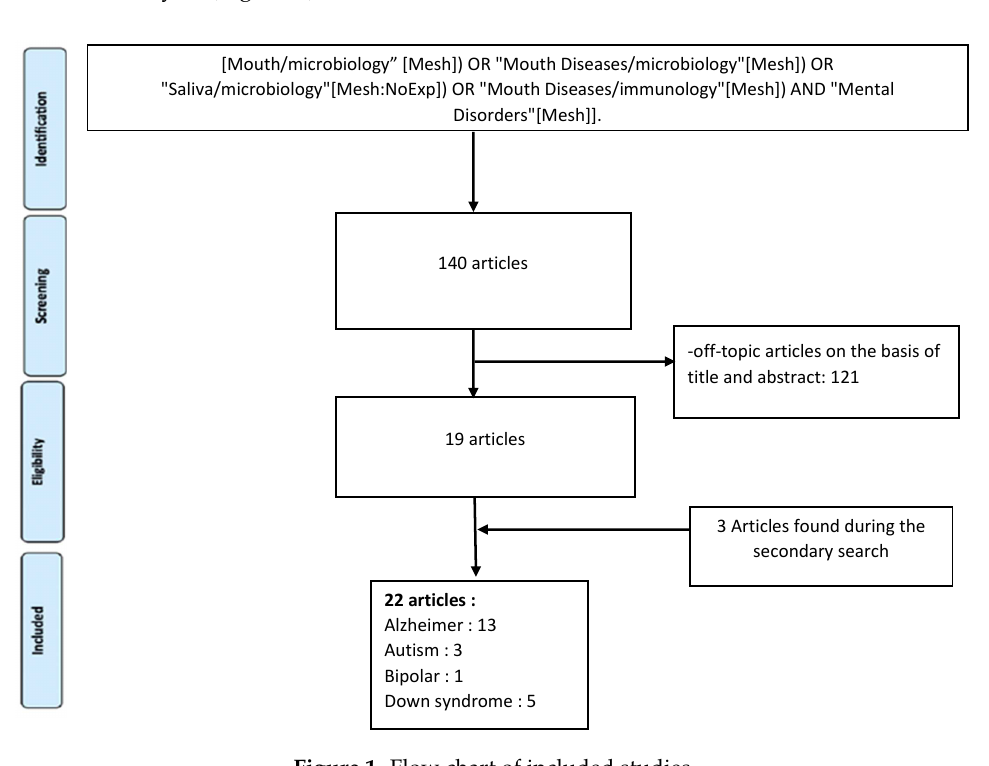
Figure 1. Flow chart of included Figure 1 : Flow chart of included studies